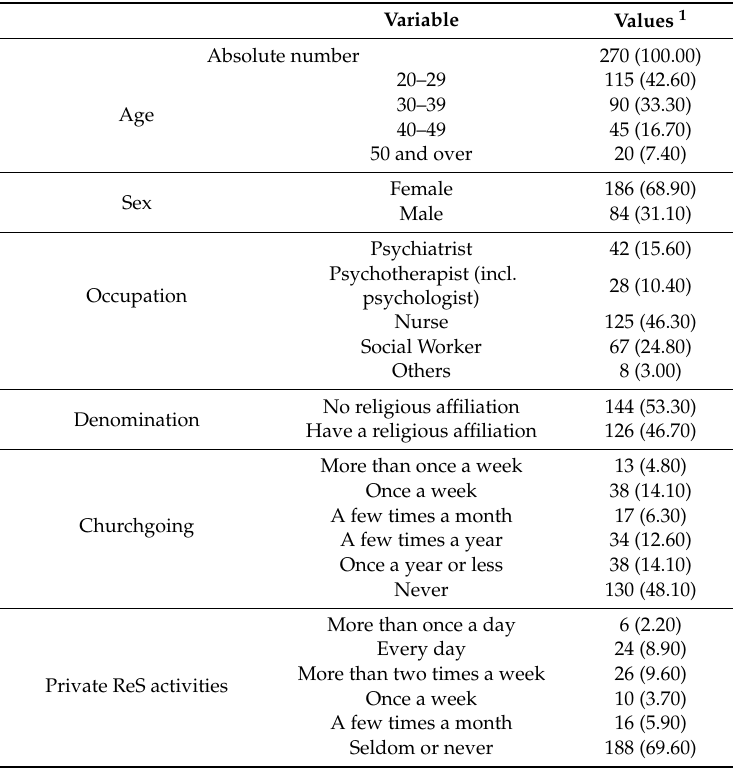
Table 1. Characteristics of survey